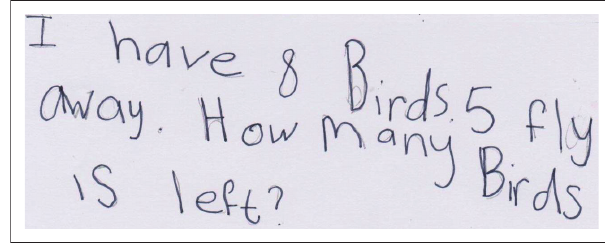
FIGURE 3: Learner-generated example of a word problem for 8 minus 5.